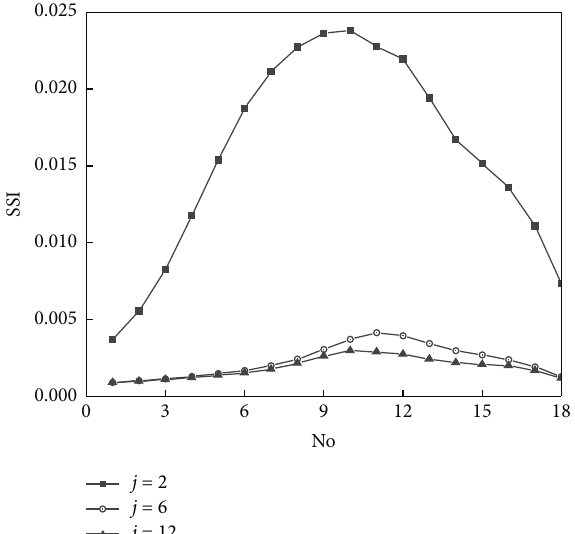
Figure 17: Shear strain increment of bedrock.